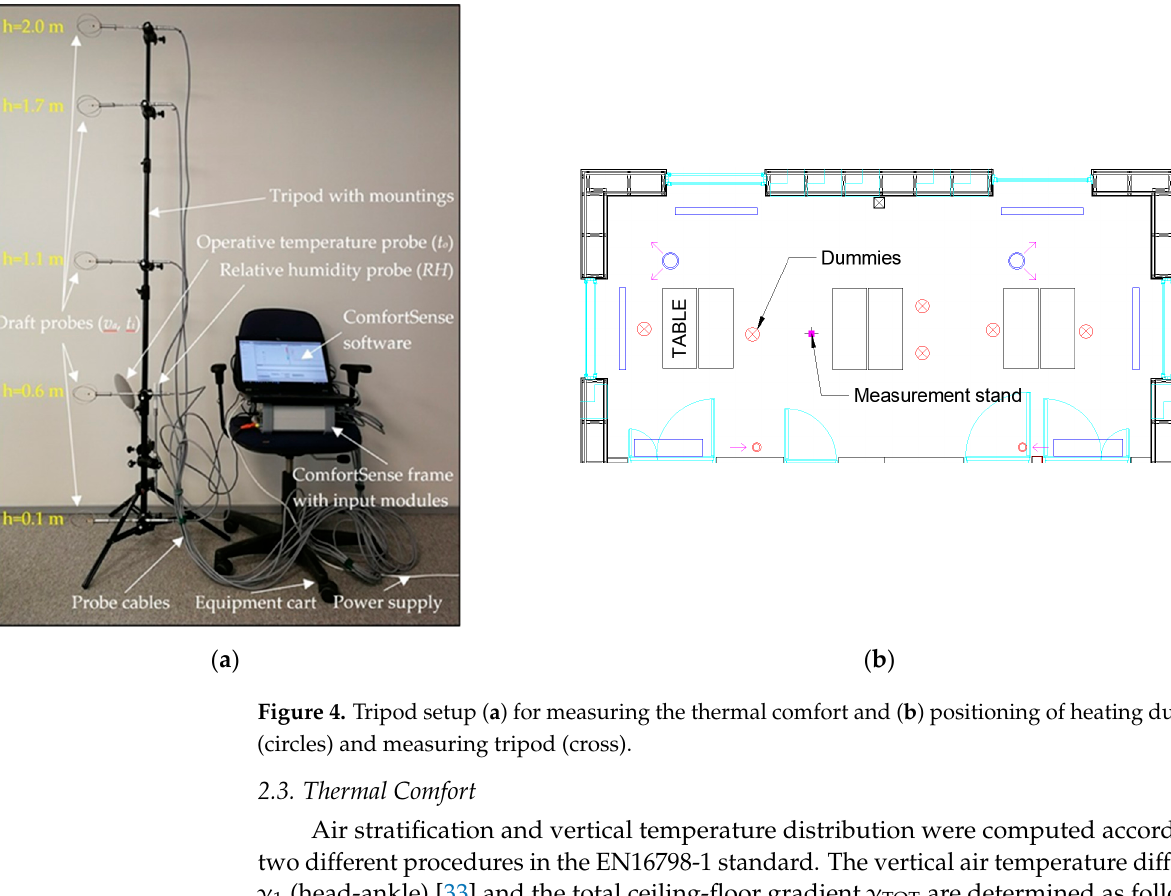
Figure 3. Measuring tripod ( a ) and heating dummy ( b ).